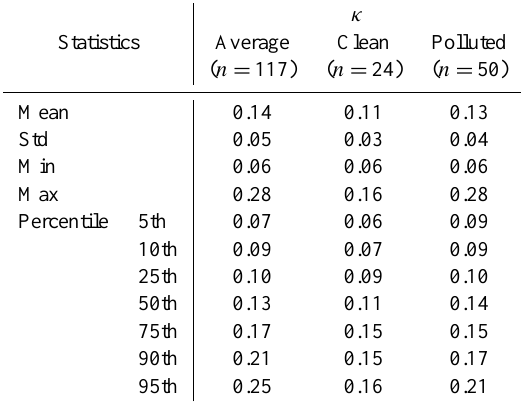
Table 3. Statistical results of the mean hygroscopicity parameter κ , derived from f (RH) observations ( n denotes the sample size corre- sponding to each